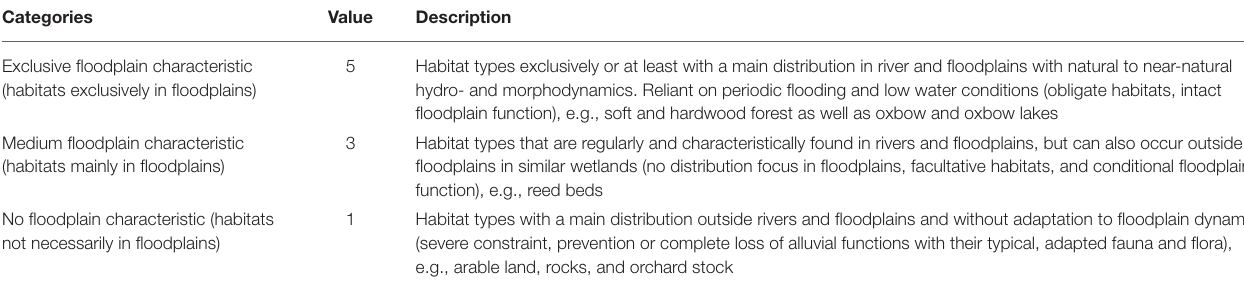
TABLE 2 | Categories and associated values of the floodplain specific habitat value (based on Breunig et al., 2000, unpublished). Categories